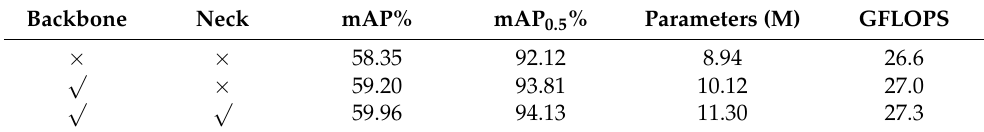
Table 3. Results of the ablation experiments of the Transformer encoder added in different